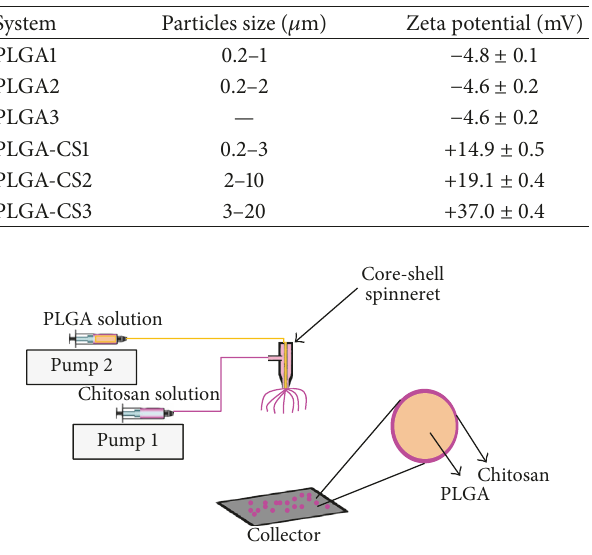
Figure 1: Scheme of electrospinning process for fabrication of